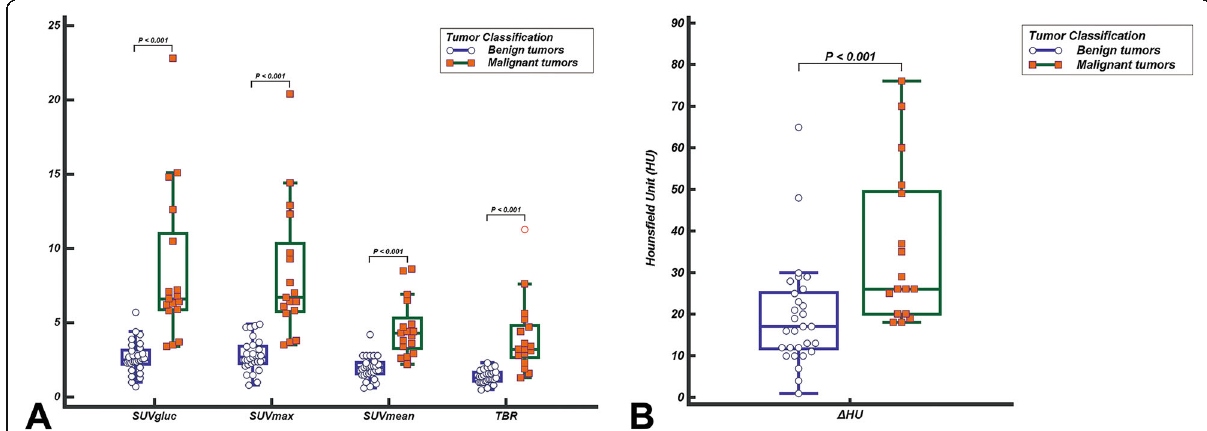
Fig. 2 Median comparison of 18 F-FDG uptake ( a ) and the enhancement ( b ) of tumors. There was a statistically significant difference in the median between benign and malignant groups ( P <